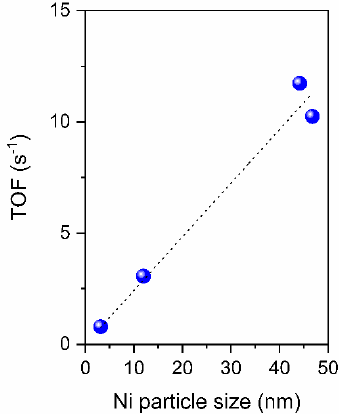
Figure 6. Turnover frequency of CO 2 conversion as a function of the average Ni particle size; reaction conditions: reactant mixture CO 2 :H 2 :N 2 :He = 1:4:2:13, catalyst mass = 40 mg, GHSV = 300 L g − 1 h − 1 .